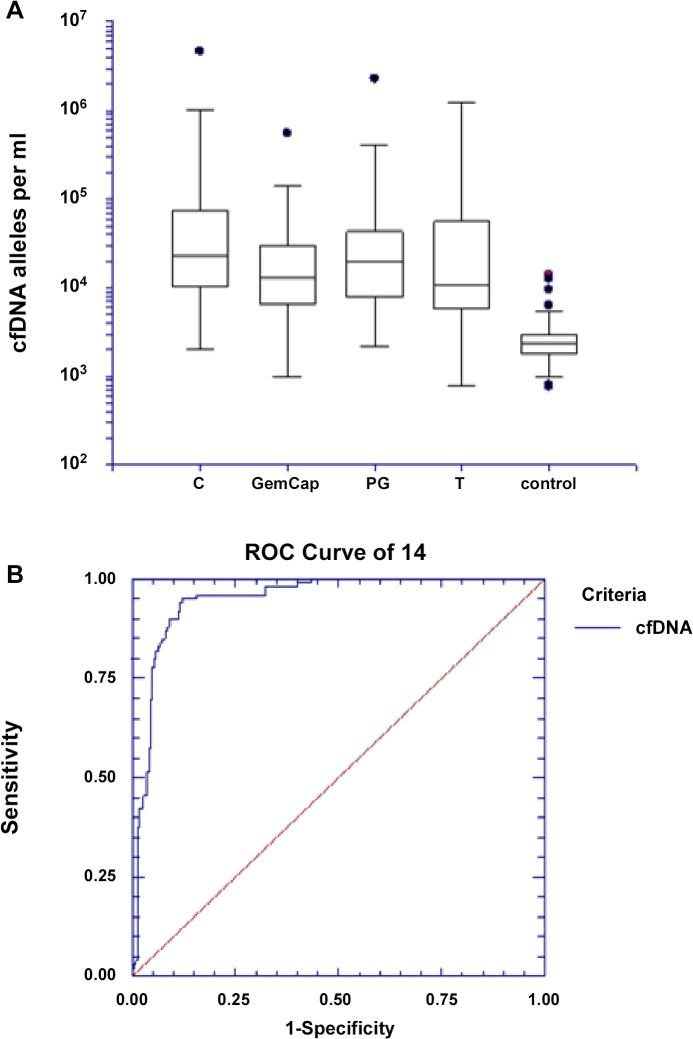
A and B. Cell free DNA concentrations in colorectal cancer cohorts and healthy controls.
A depicts Box and whisker plots with 25%, 50%, 75% percentiles, upper and lower adjacent values and outliers (dots). Horizontally the four clinical trial cohorts and control group, vertically the cfDNA concentration on a logarithmic scale. C cetuximab study, GemCap GemCap cohort, PG PG study cohort, T TIRASMUS study cohort, Controls healthy control group. B Shows a receiver operating curve (ROC) estimating the performance of cfDNA to discriminate between colorectal cancer patients and controls. The AUC was 0.9486, (95% CI 0.9182–0.9679, p<0.00001).